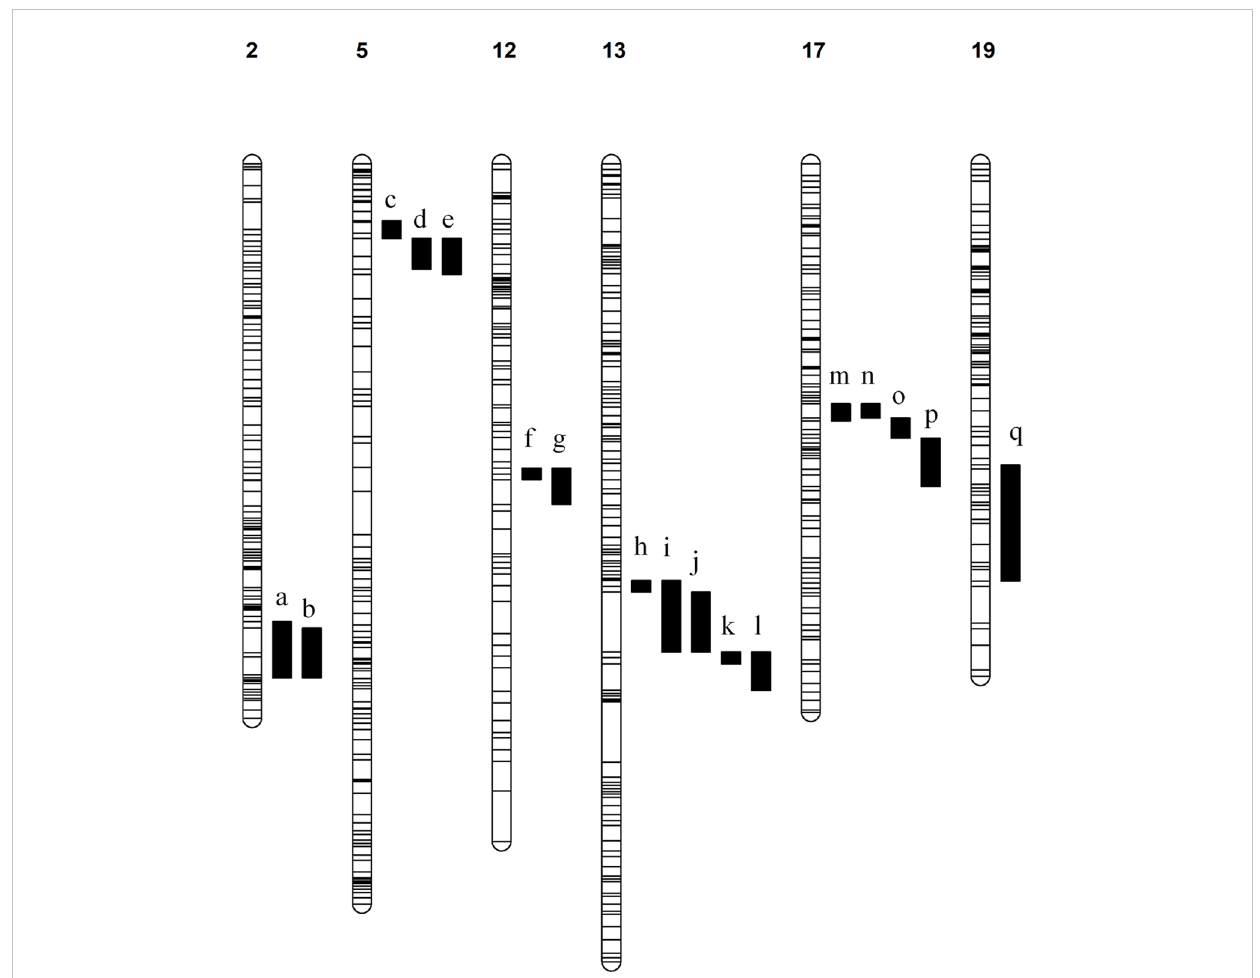
monoterpene accumulation, while GT-progeny displayed relatively increased monoterpene accumulation levels, with a continuous variation in distribution (Figure 4). Orthogonal partial least squares (OPLS) analysis of the full volatile dataset across the population and VvDXS1 genotypes show that the population clearly segregates for the SNP (Figure S4). The population segregate for the SNP across principal component 1 (PC1) which explains 27.1% of the